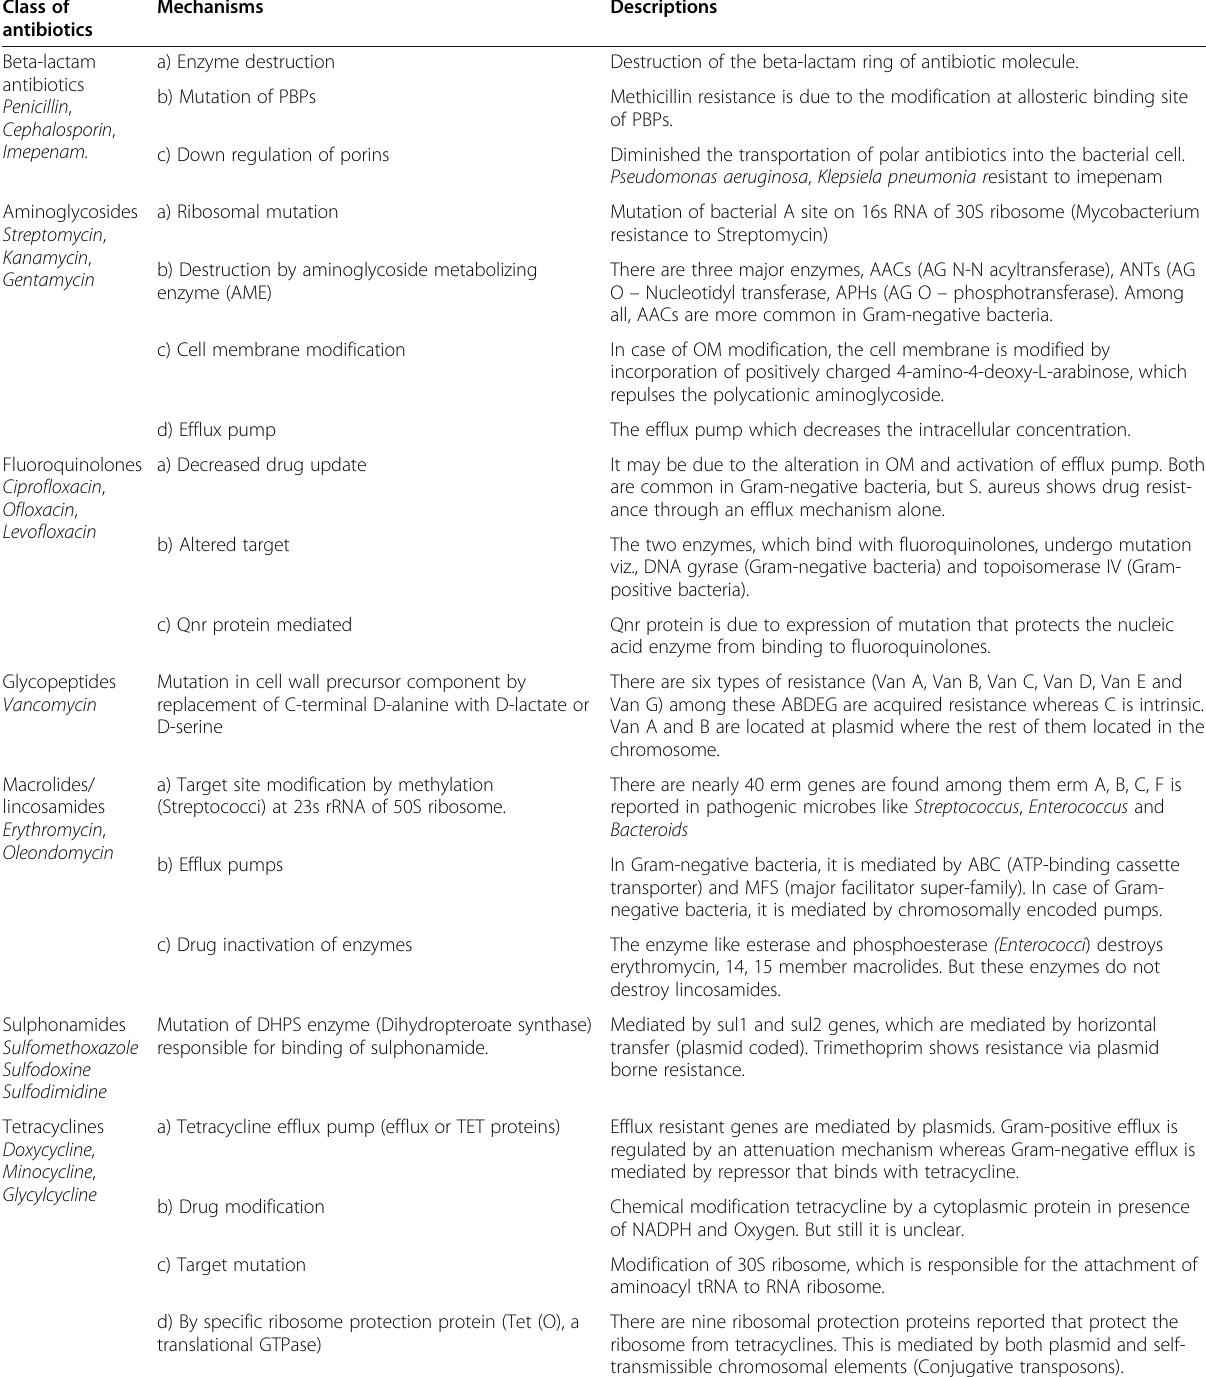
Table 2 Reported mechanisms of drug resistance for various